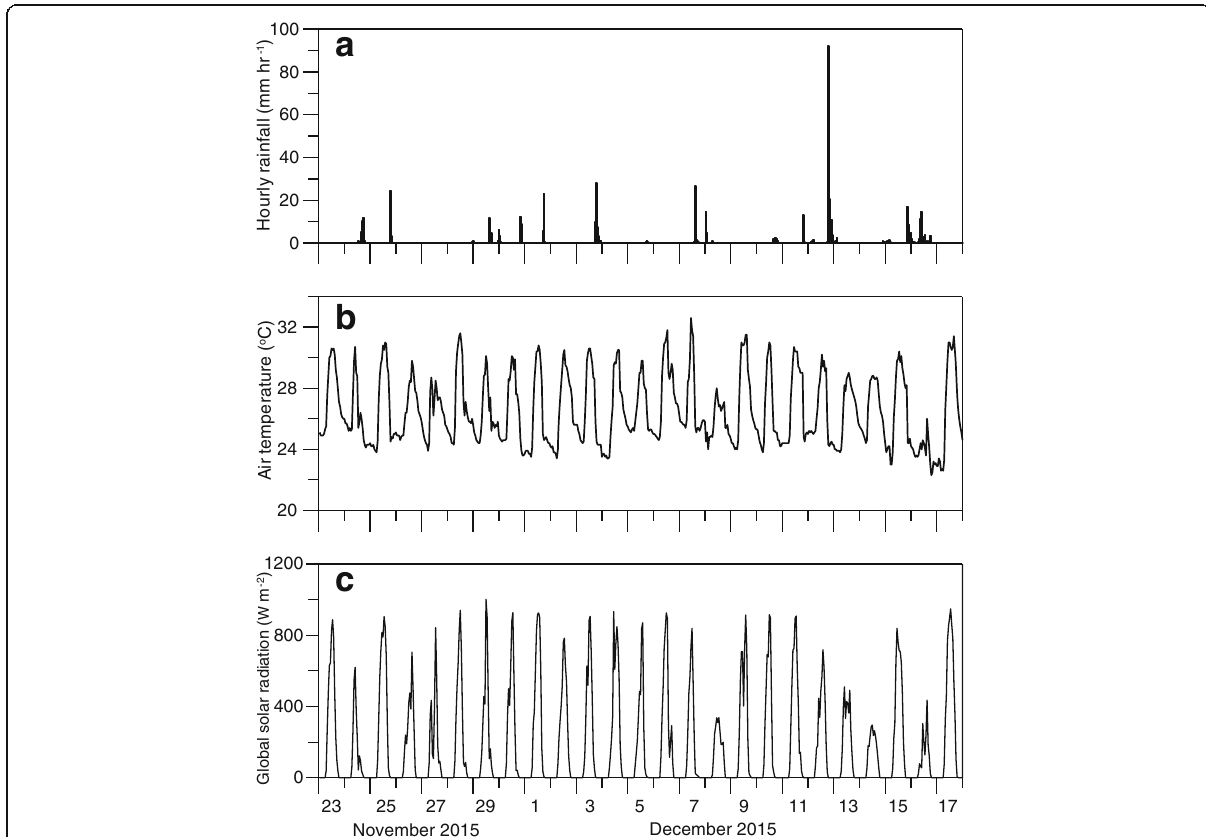
Fig. 2 Time series of a hourly total rainfall, b hourly averaged surface air temperature, and c hourly averaged global solar radiation observed at Bengkulu Meteorological Observatory (3°51 ′ 30 ″ S 102°20 ′ 11 ″ E) on Sumatra Island from 23 November to 17 December 2015. The tick marks in the abscissa indicate 00 LT for each of the days within the time period